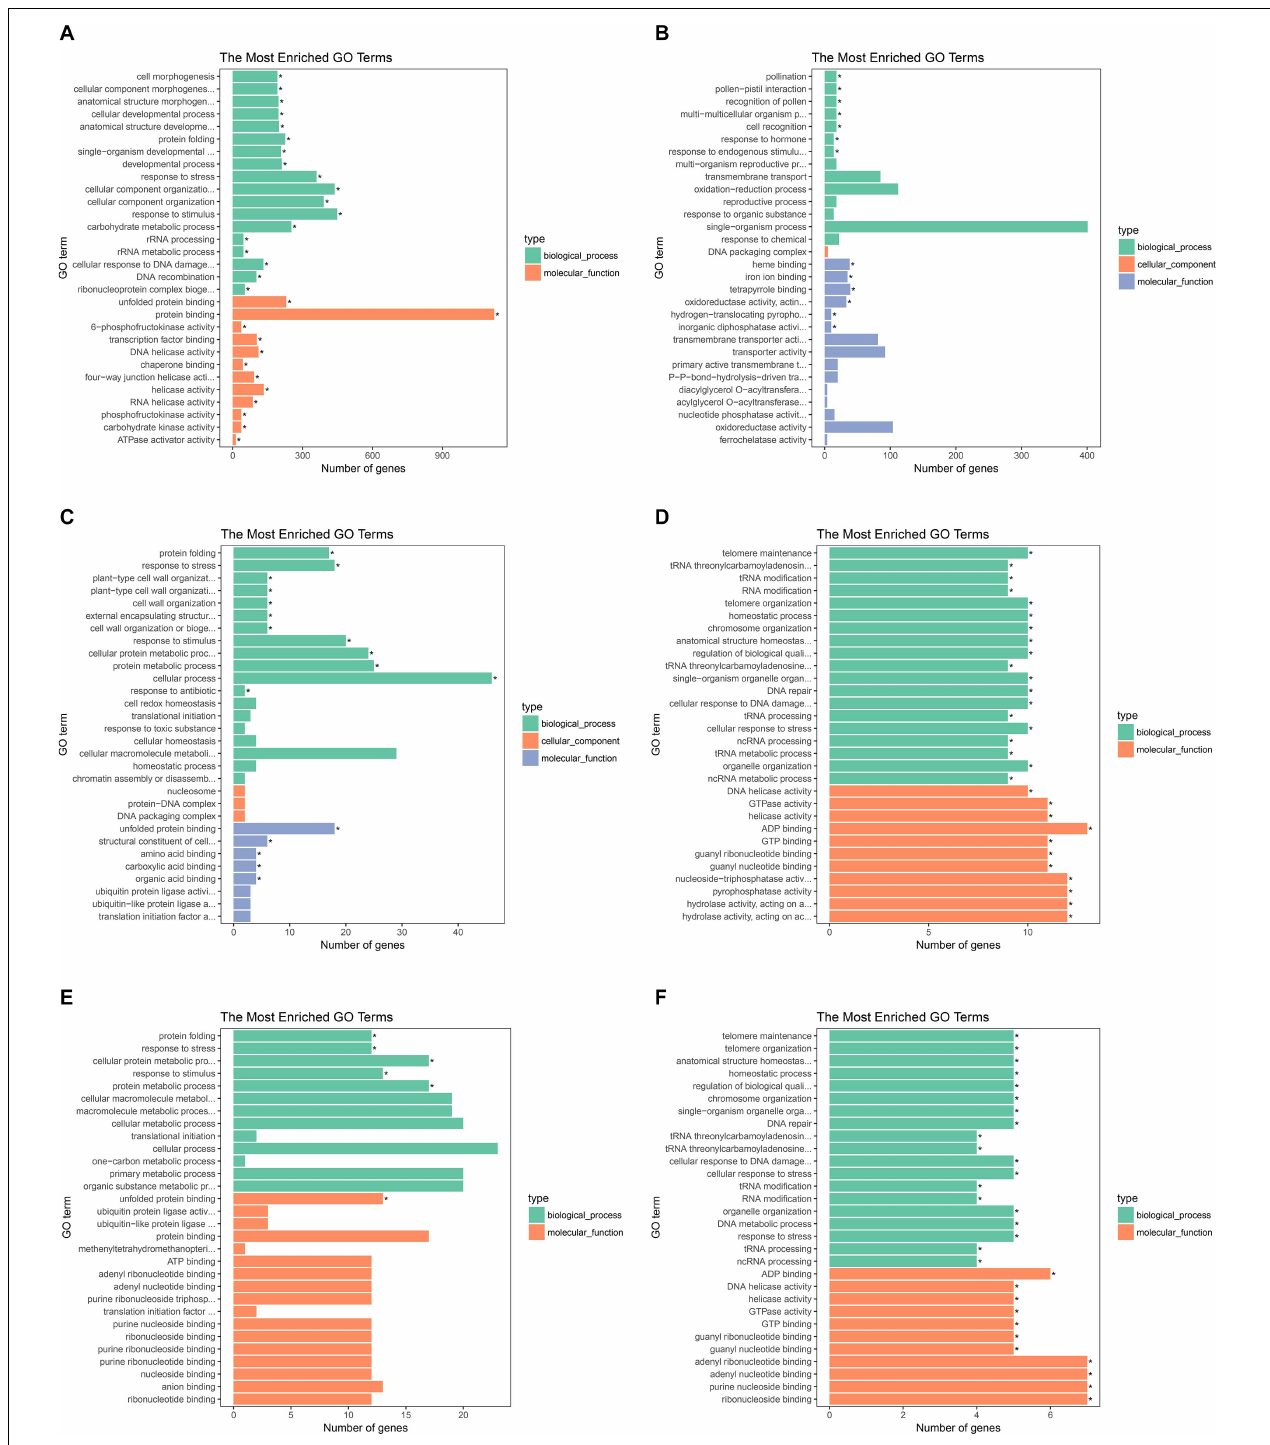
FIGURE 3 | GO analysis of the biological function of genes, lncRNAs, and target genes of lncRNAs. GO terms of up- (A) and down-regulated genes (B) , up- (C) , and down-regulated lncRNAs (D) . And up- (E) and down-regulated target genes of lncRNAs (F) .